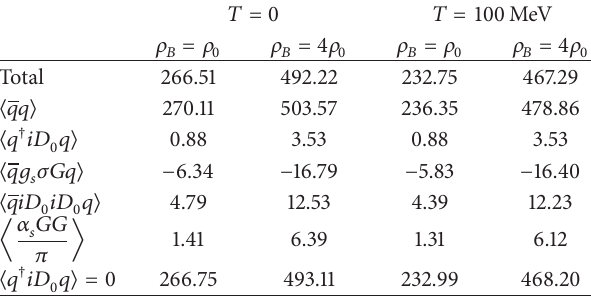
Table 3: (Color online) The following table gives the values of mass shift of axial vector mesons 𝐵 1 (in MeV units) due to individual condensates at temperatures 𝑇 = 0 and 100MeV. For each value of temperature the values are tabulated for baryon densities 𝜌 𝐵 = 𝜌 0 and 4𝜌 0